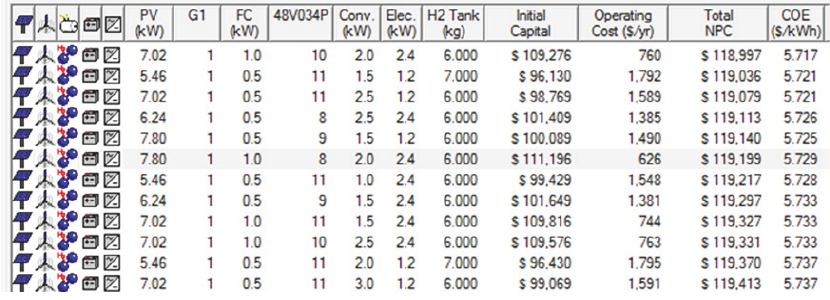
Figure 4: Suggested results simulation by HOMER software.